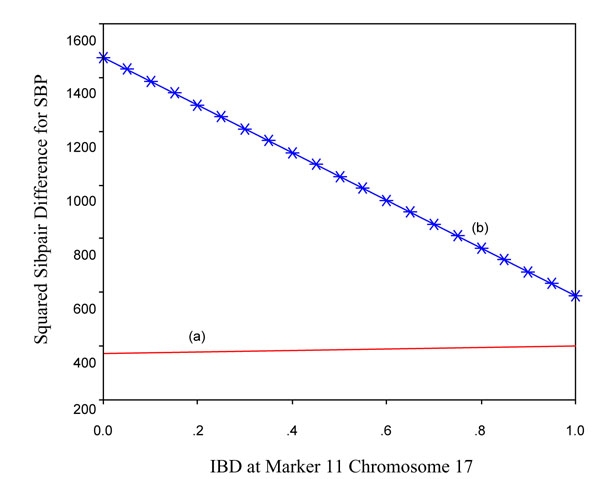
Haseman-Elston regression lines at D17S2180 for (a) all eligible sib pairs and (b) node 10 subgroup.